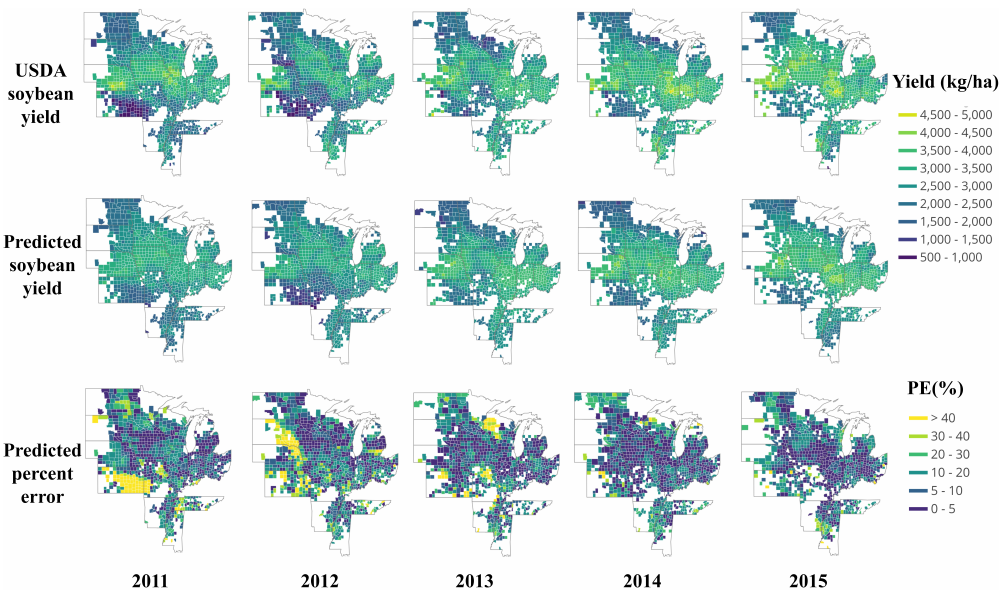
Figure A5. Map of USDA soybean yield, LSTM in-season predicted soybean yield and PE from 2011 to